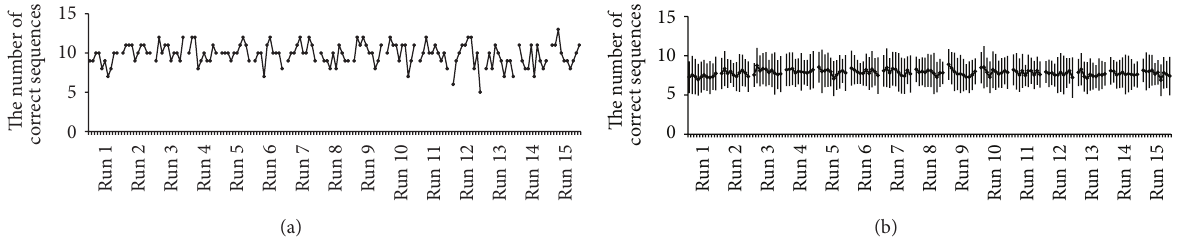
Figure 2: (a) Trial-by-trial fluctuation in the number of correct sequences in a representative participant. (b) Mean number of correct sequences across all 15 participants. The error bar indicates ± 1